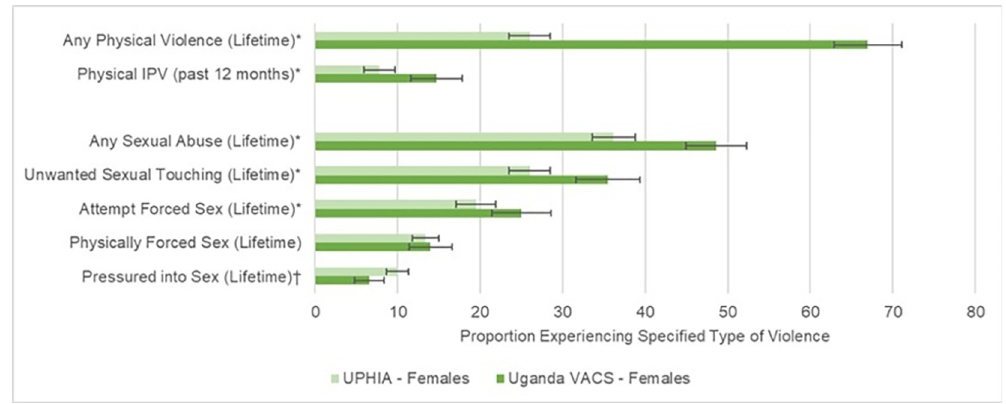
Fig 2. Lifetime and past-12-month prevalence of sexual and physical violence in females aged 15–24 years in Uganda Population-based HIV Impact Assessment (UPHIA 2016–2017) and Uganda Violence Against Children Survey (VACS 2015). Violence domains include lifetime physical violence, physical intimate partner violence (IPV) in the past 12 months, and lifetime sexual violence. Asterisks ( � ) indicate significantly higher prevalence in VACS than UPHIA (p < 0.05). Daggers ( † ) indicate significantly higher prevalence in UHPIA than VACS (p <